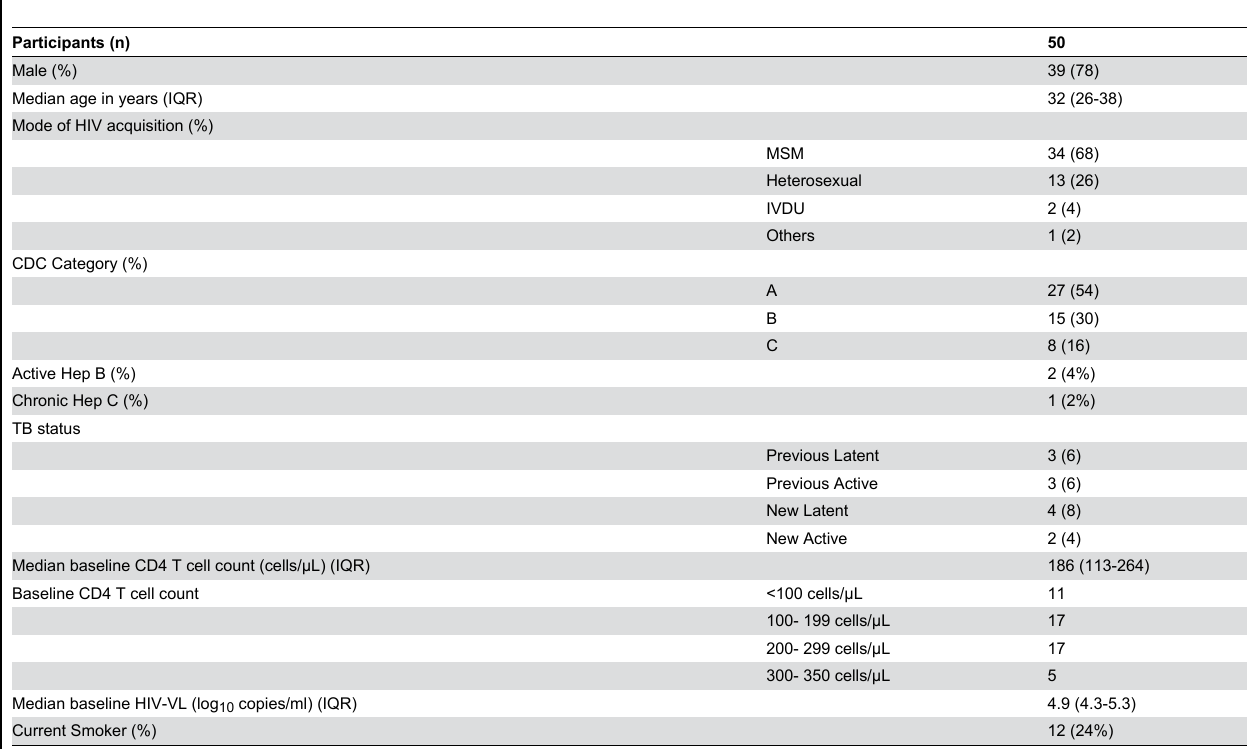
Table 1. Baseline characteristics of the participants in the RESTORE